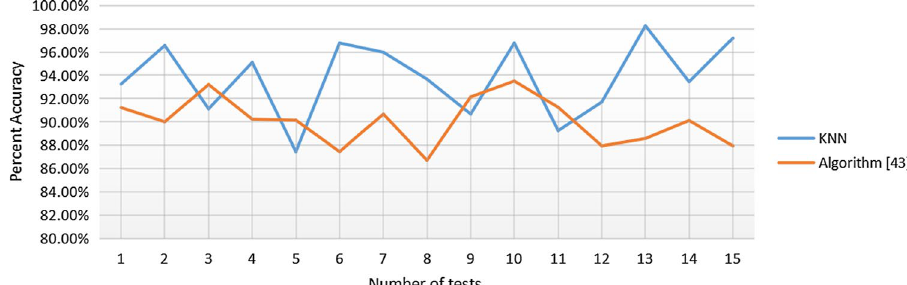
Fig. 3 Average accuracy rate (Double degree of